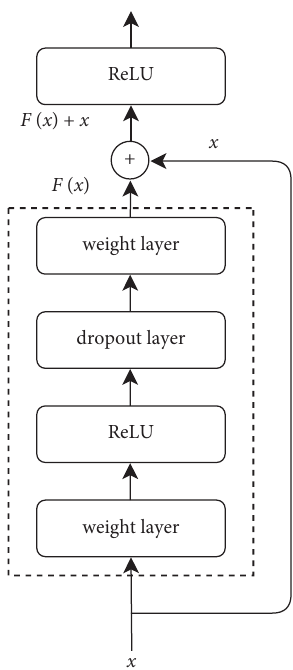
Figure 1: Structure diagram of the improved residual